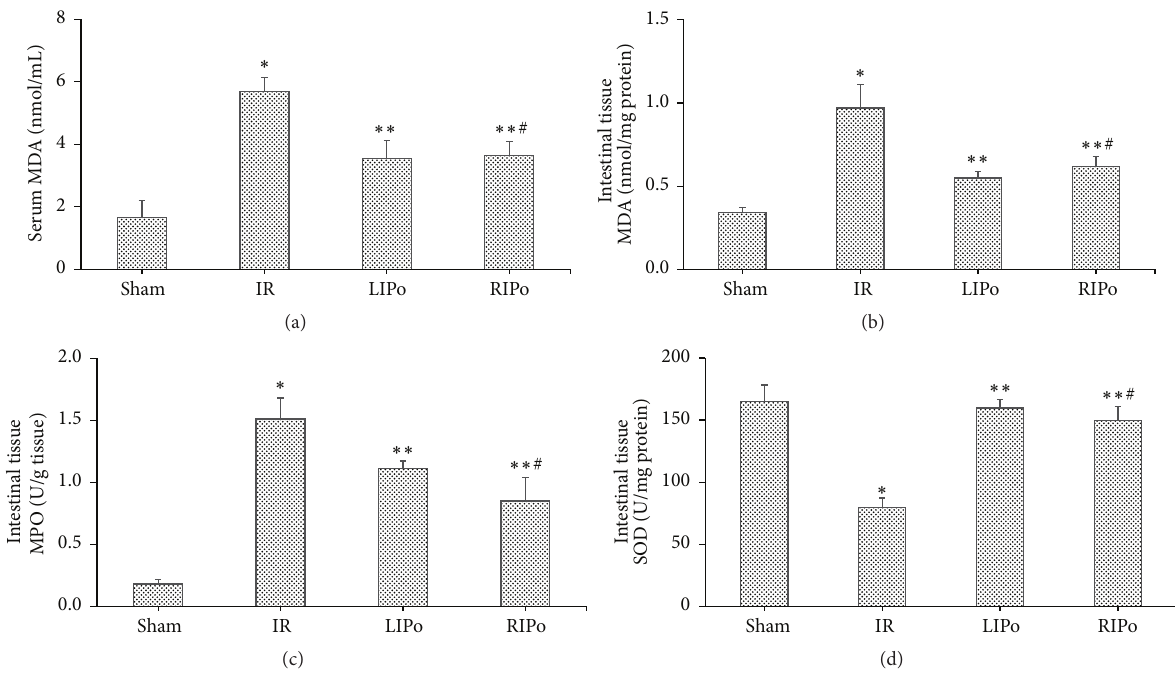
Figure 3: Effects of LIPo and RIPo on MDA, MPO, and SOD levels. Serum MDA (a), intestine MDA (b), MPO (c), and SOD activity (d). Data are mean ± SD, 𝑛 = 6 . ∗ 𝑝 < 0.05 versus the sham group; ∗∗ 𝑝 < 0.05 versus the I/R group; # 𝑝 > 0.05 versus the LIPo group ((a), (b), and (d)); # 𝑝 < 0.05 versus the LIPo group